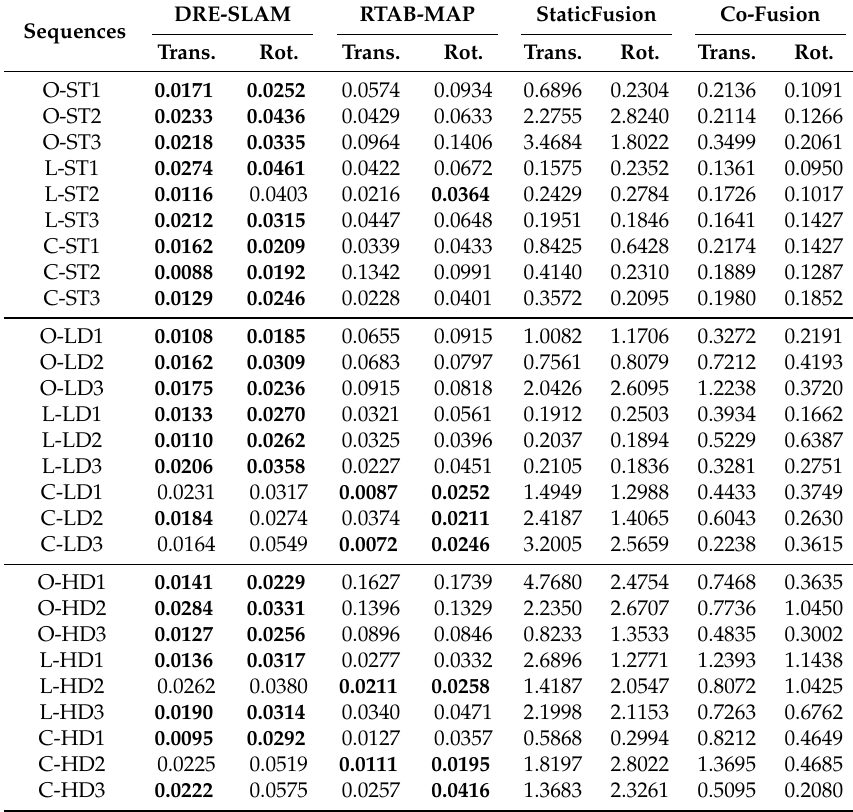
Figure 10. The trajectories of DRE-SLAM are smooth and fit well with the ground truth. Table 1. The root-mean-square-error (RMSE) of the translation (m) and the rotation (rad) of the four methods in all the sequences. The numbers in bold represent the minimum